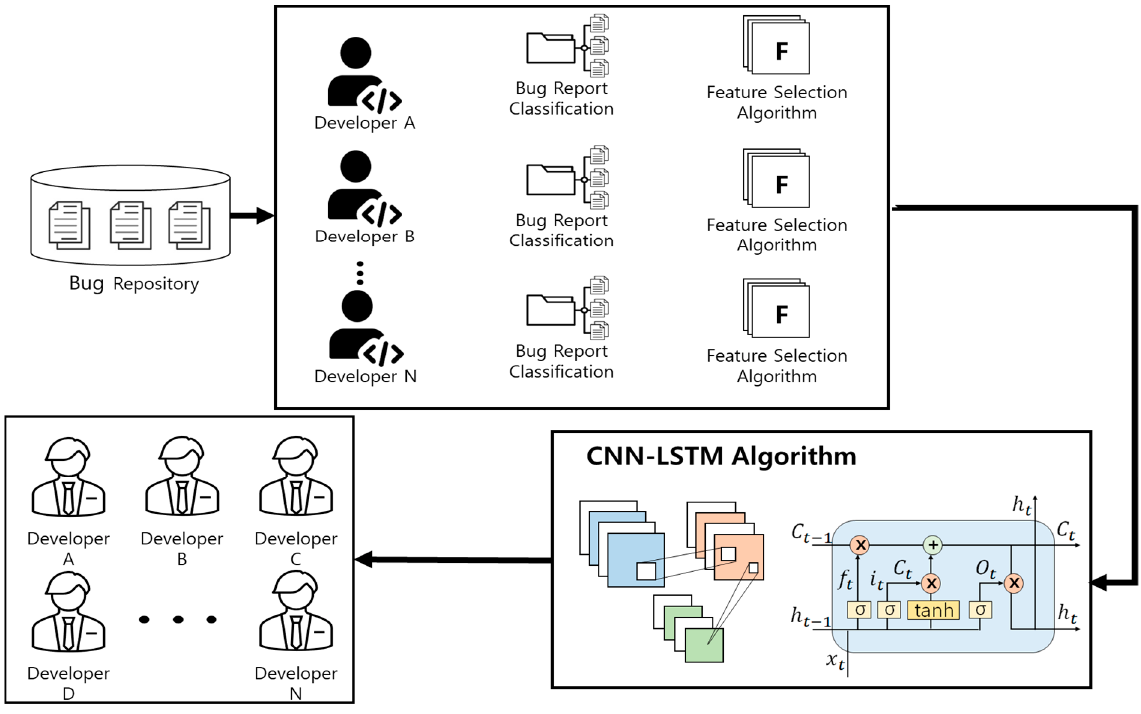
Figure 3. Schematic of the proposed